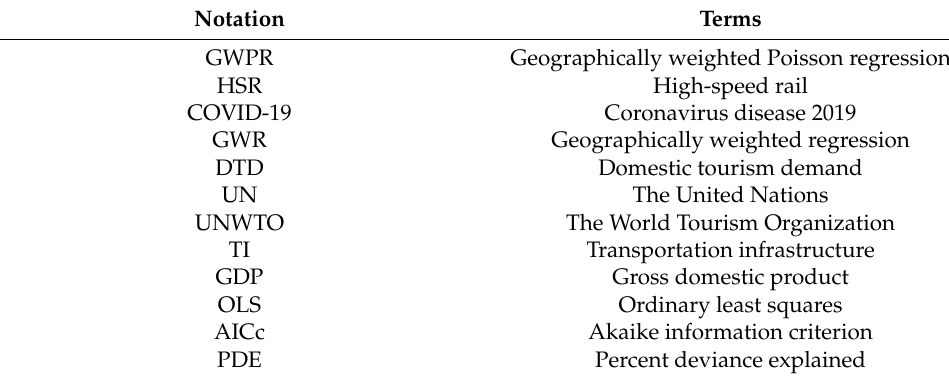
Table A1. Summary of